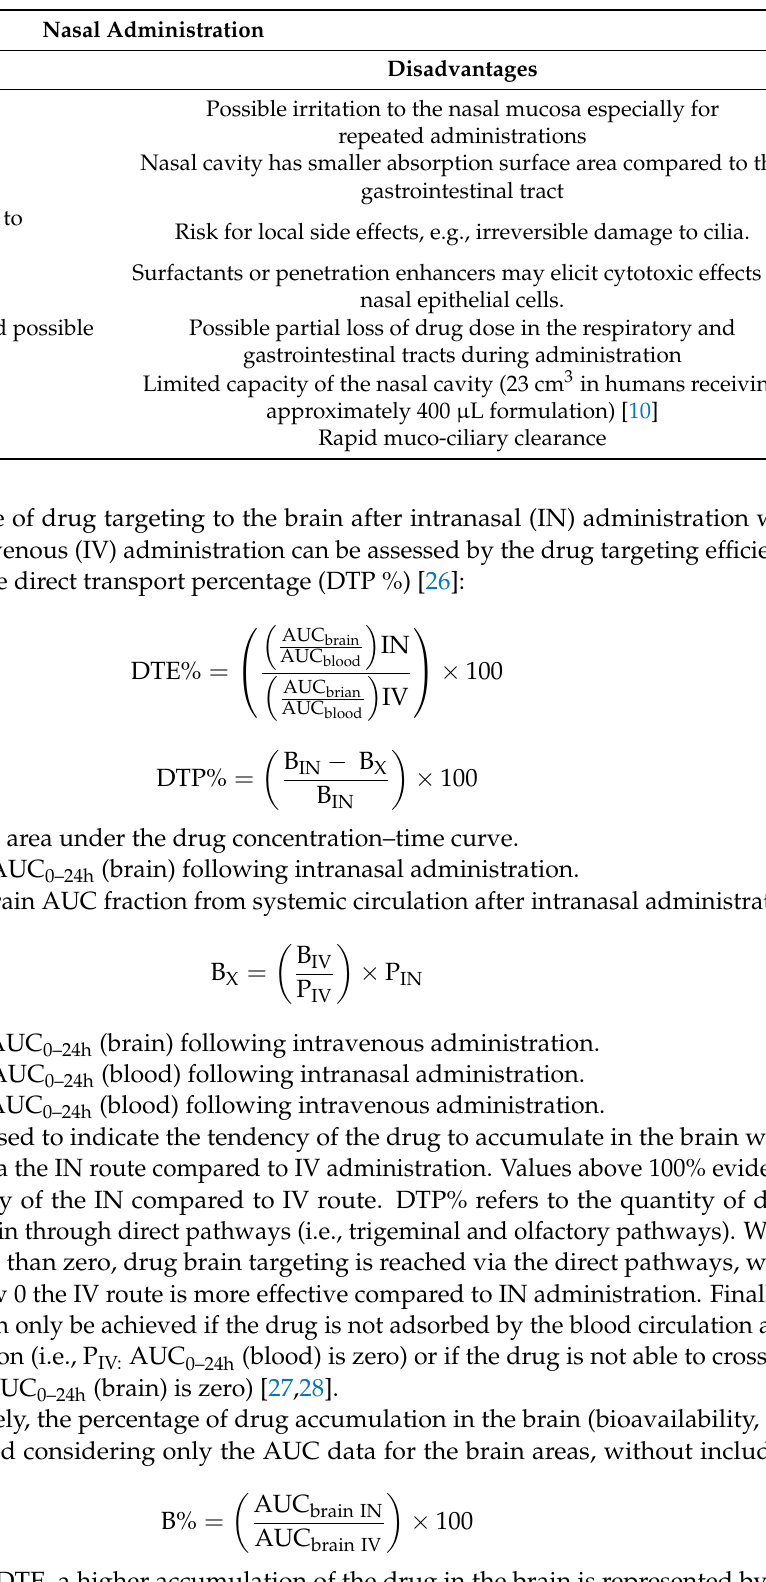
Table 1. Summary of main advantages and disadvantages of the IN route for drug delivery to the